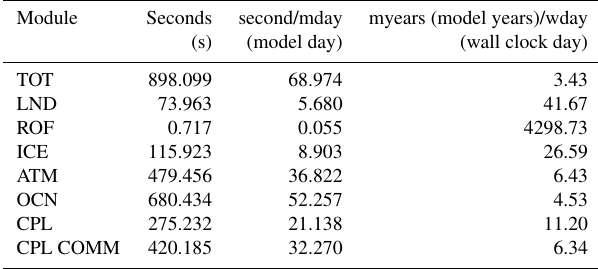
Table 9. The current CPE parallelism speeding rate of CESM-HR configured on 65000